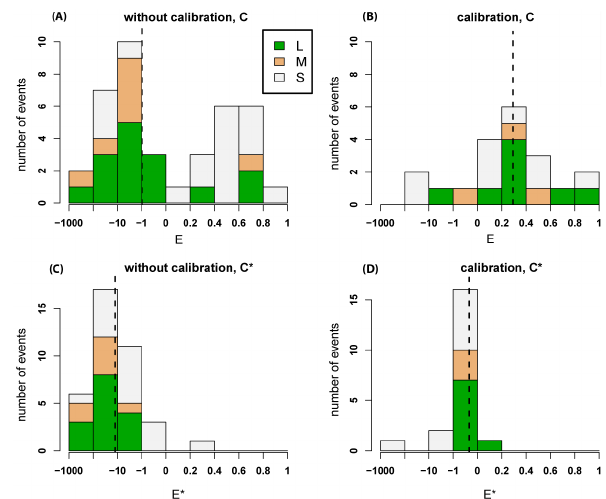
Fig. 5. Nash–Sutcliffe index ( E ) in the L, M and S catchment cal- culated for the closure relations C (top panels, A and B ) and C ∗ (bottom panels, C and D ). Left panels, without calibration; right panels, with calibration. Vertical dashed lines indicate the median of the Nash–Sutcliffe index. Note that plots on the right panel show the evaluation only with the validation events.